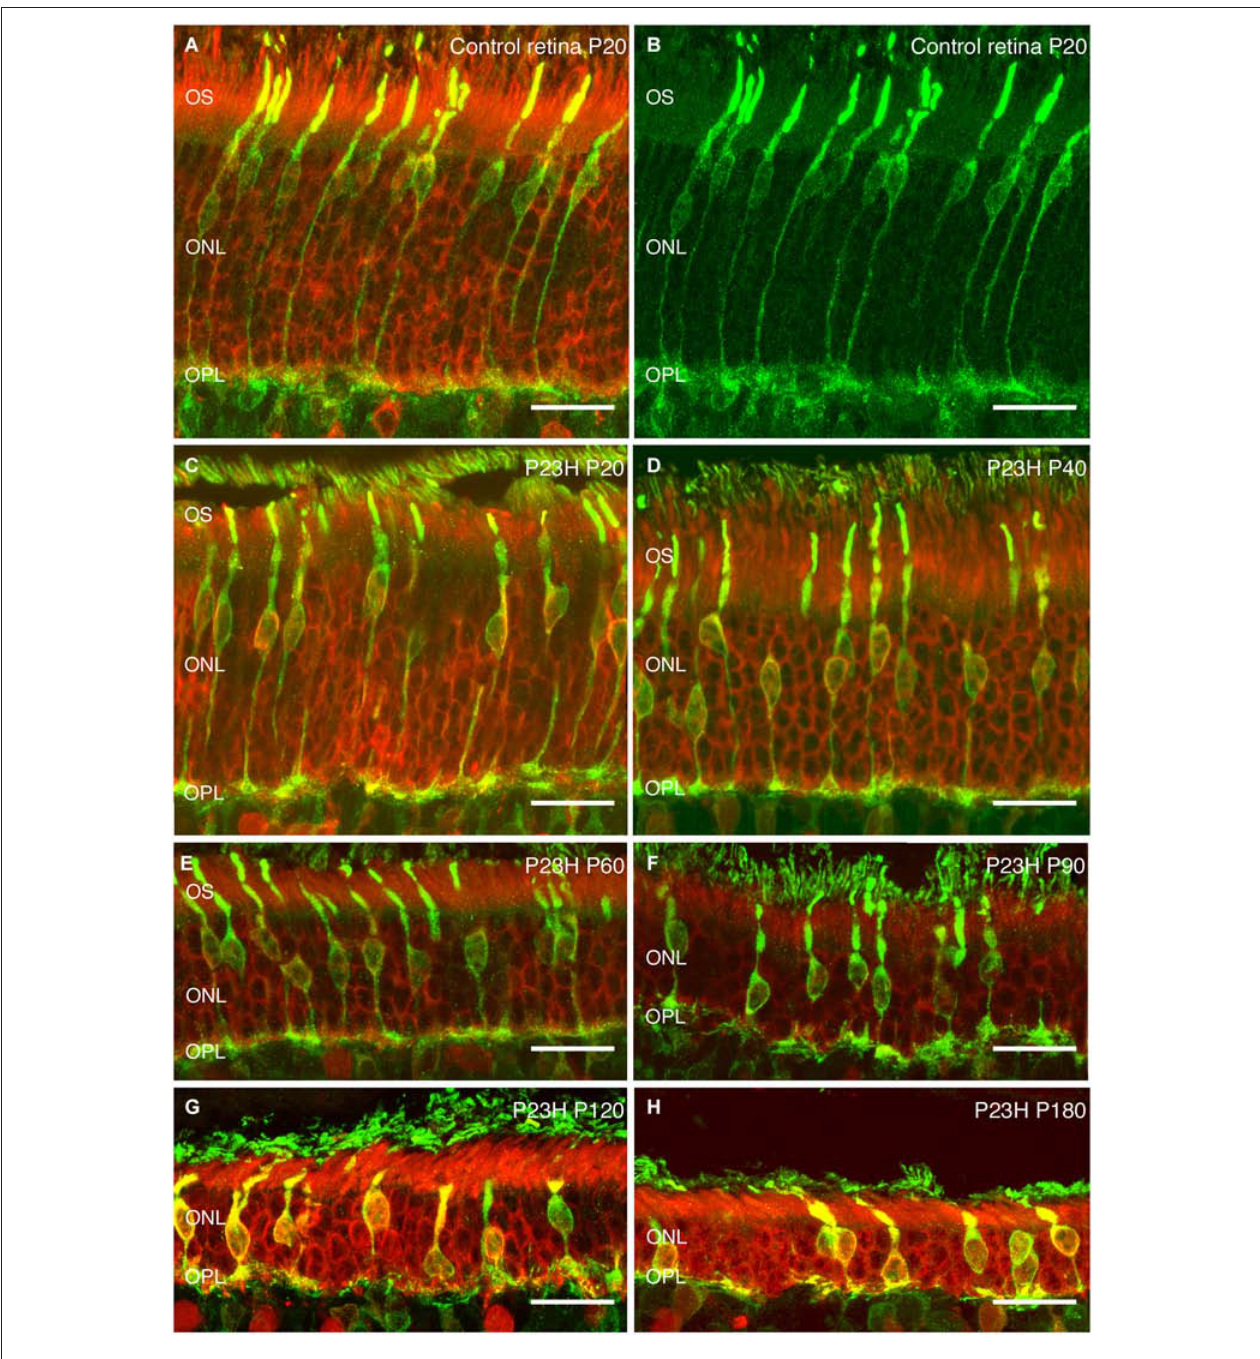
control rat retina stained with recoverin (A) and cone-photoreceptor cells stained with transducin (A,B) . P23H-L1 shows a decrease in photoreceptor rows and morphology changes from P20 to P180 (C–H) . OS: Outer segments; ONL: outer nuclear layer; OPL: Outer plexiform layer. Scale bar: 20 µ